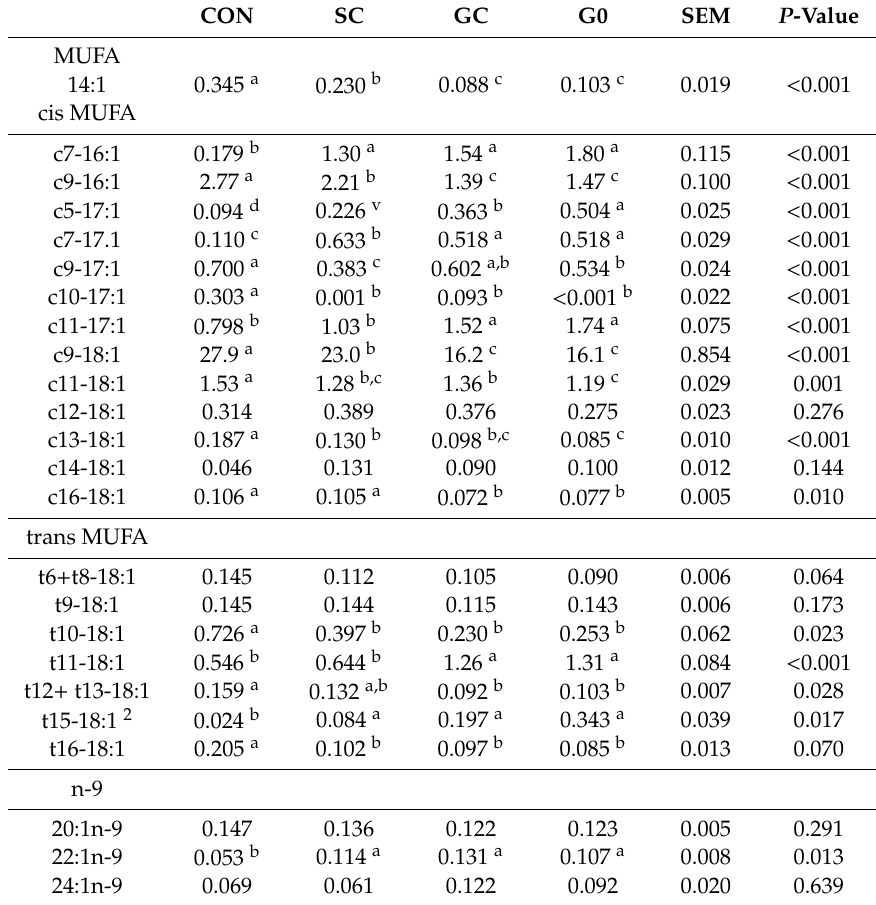
Table 5. Individual monounsaturated fatty acid (MUFA) proportion (of total fatty acids 1 ) in the longissimus thoracis muscle from bulls assigned to one of the following systems: grass silage plus barley-based concentrate ad libitum (CON); grass silage ad libitum plus 5 kg of concentrate (SC); grazed grass without supplementation (G0) or grazed grass plus 0.5 kg of the dietary dry matter intake as concentrate (GC) until slaughter at 15